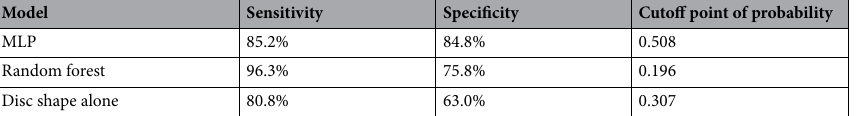
Table 4. Sensitivity and specificity of each model at optimal cutoff point. Optimal cutoff was considered the point maximizing the sum of sensitivity and specificity. MLP multilayer